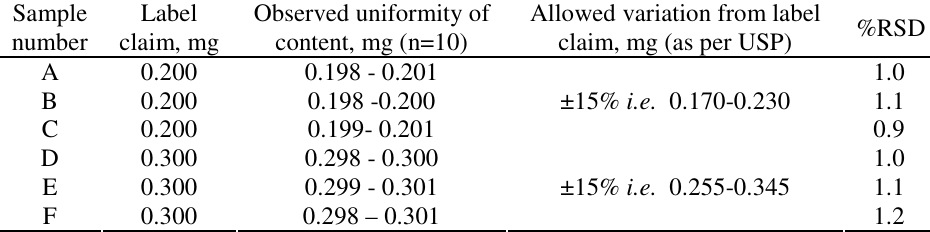
Table 2. Results obtained for uniformity of content for the six formulations using LC-MS/MS